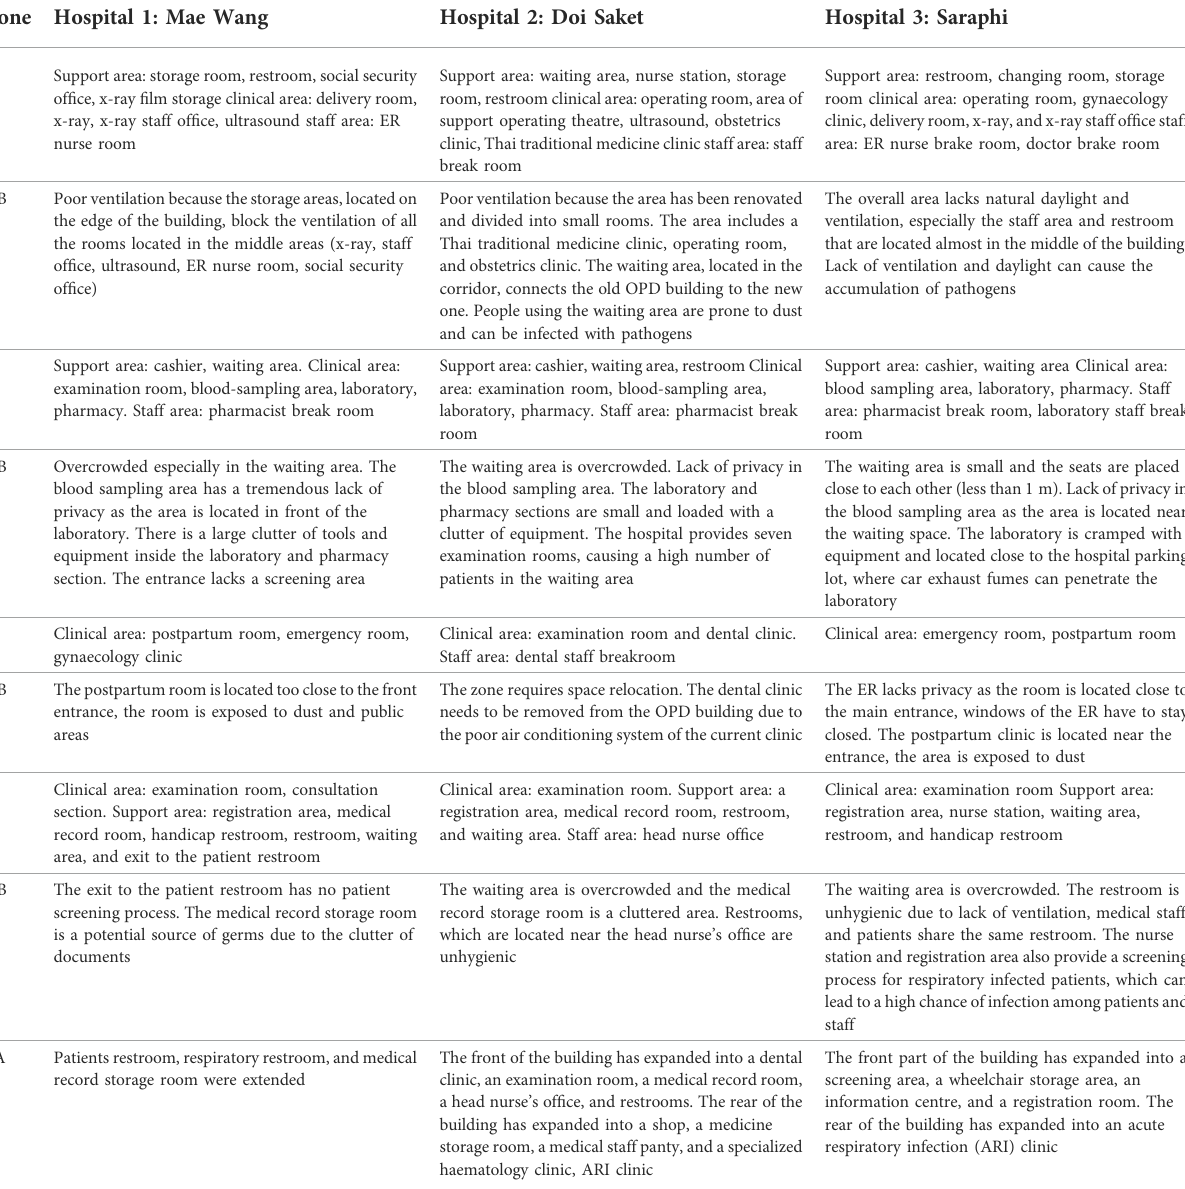
TABLE 3 OPD building observation of the three